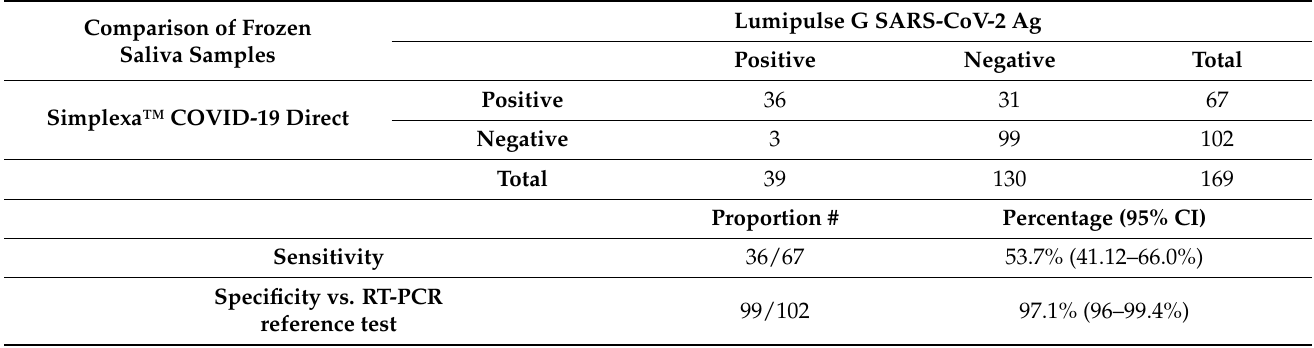
Table 3. Comparison of Lumipulse G SARS-CoV-2 Ag data vs. molecular reference test (Simplexa ™ COVID-19 Direct) on frozen retrospective saliva samples. Comparison of Frozen Saliva